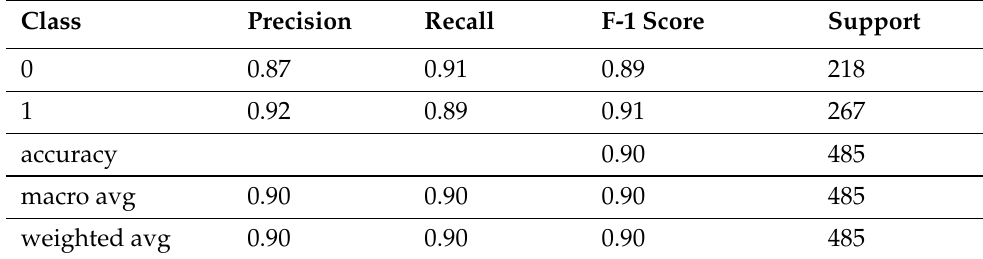
Table 12. Classification report for BERT.